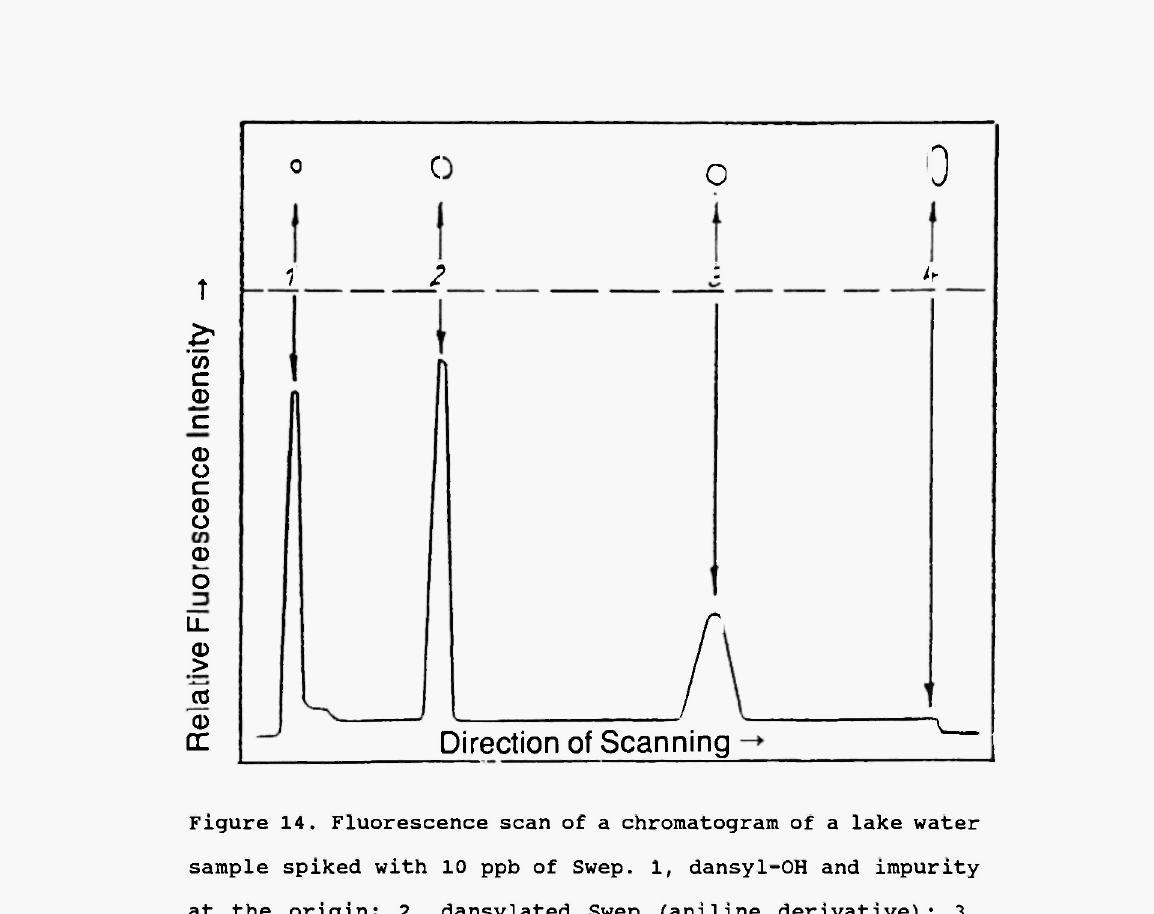
Figure 14. Fluorescence scan of a chromatogram of a lake water sample spiked with 10 ppb of Swep. 1, dansyl-OH and impurity at the origin; 2, dansylated Swep (aniline derivative); 3, excess of dansyl chloride; 4, impurities in the region of the solvent front. (Reproduced with permission from TLC Report, IV/3—19, GIT Verlag